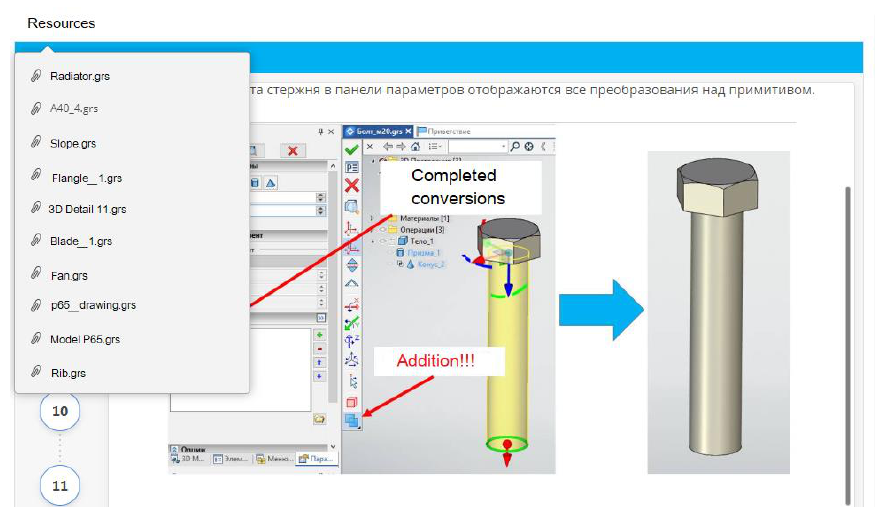
Fig. 11. 3D model blanks in course resources for developing 3-dimensional design